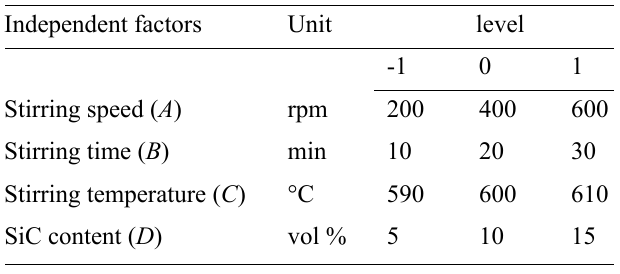
Table 2. Independent Factors and their Levels for DODE of compocasting